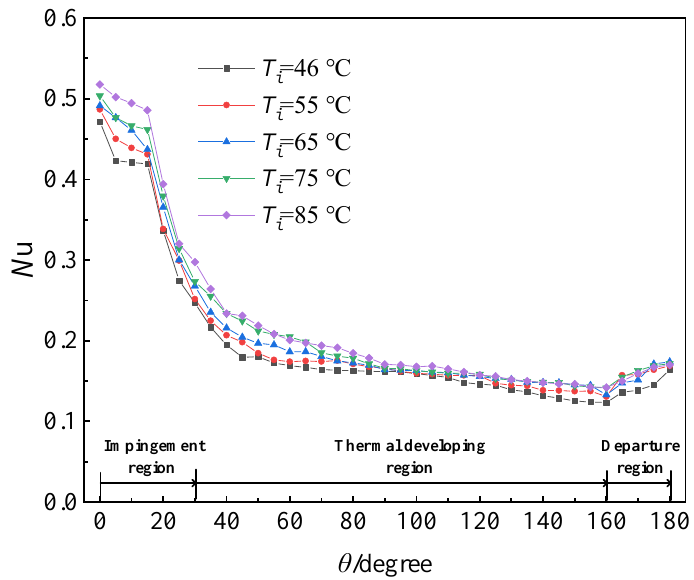
Figure 10. Local Nusselt number around tube under various spraying temperatures.